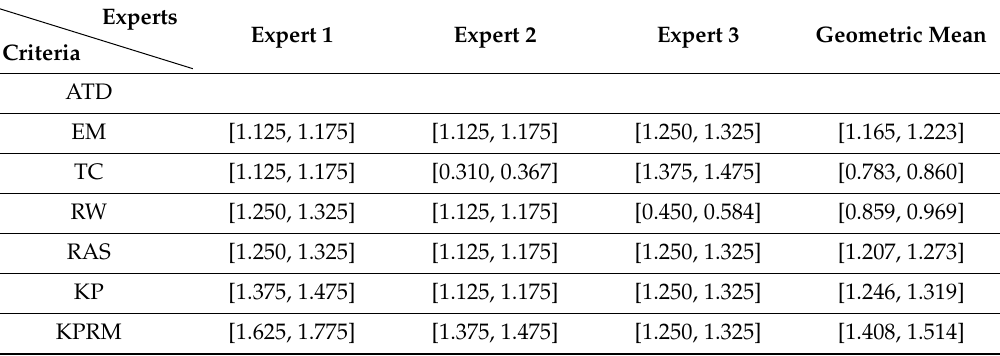
Table 5. The assessment for inverse